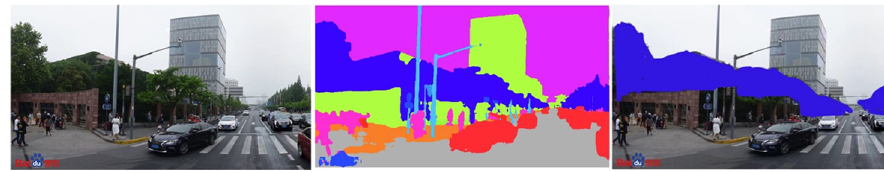
Fig 4. Greenery extraction results of two approaches.